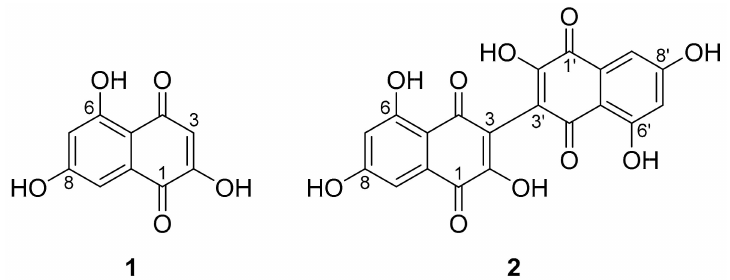
Figure 2. Chemical structures of flaviolin ( 1 ) and 3,3 (cid:48) -biflaviolin ( 2 ), secondary metabolites isolated from cultures of Hypoxylon